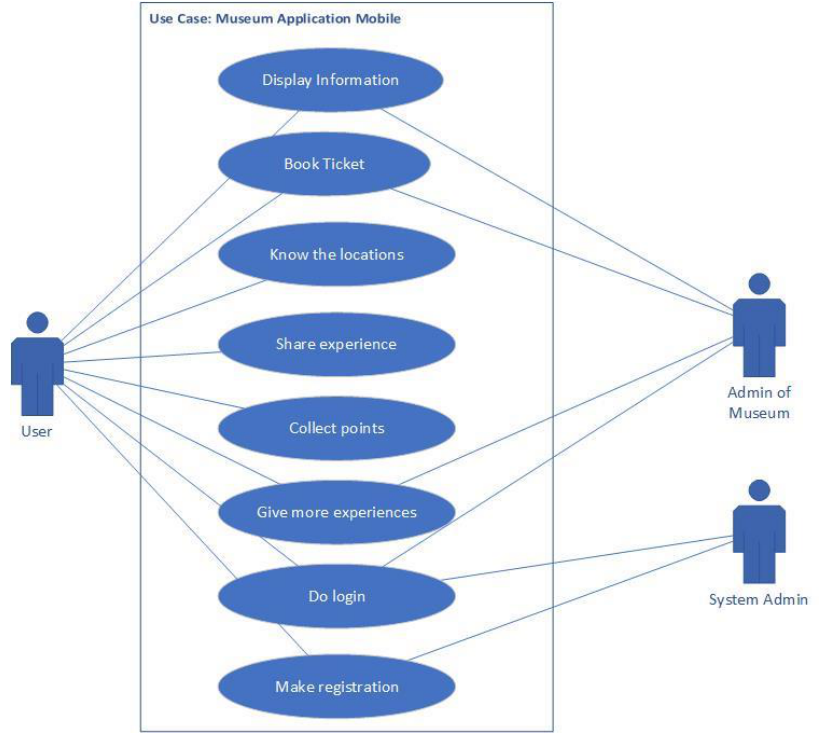
Fig. 2 Use Case Diagram 0 of Museum Application Features